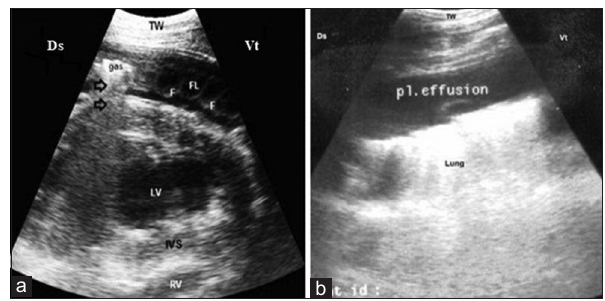
a b Figure-5: (a) Ultrasonography (US) of a buffalo with pericarditis, the echogenic fibrin interspersed with anechoic exudate, and echogenic gases with dirty shadowing (arrow) in the pericardial sac at the left 4 th ICS. (b) US of a buffalo’s lung showed clear anechoic fluid in pleural sac at the right 5 th ICS. TW=Thoracic wall, Ds=Dorsal, Vt=Ventral, Fl=Fluid, F=Fibrin, LV=Left ventricle, IVS=Interventricular septum, RV=Right ventricle.